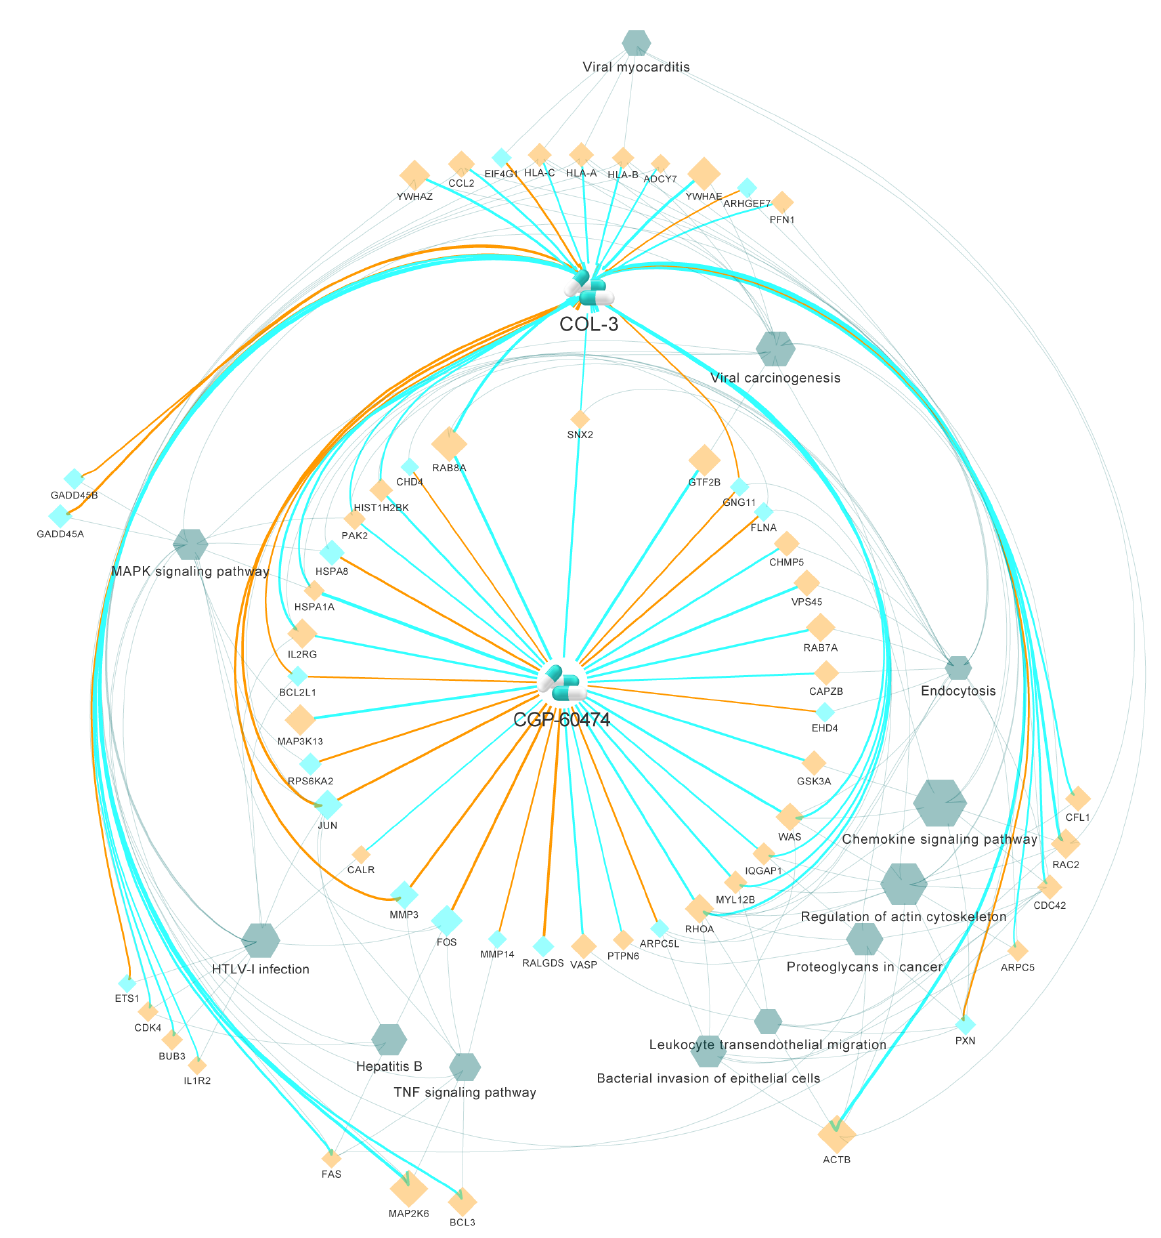
Figure 4. Target genes and pathways of COL-3 and CGP-60474 in treating lung injury in COVID-19. All pathways were significant enriched in both human COVID-19 patient lung tissues and HCC515 cells with ACE2 inhibitor inhibition. The abnormal gene expression patterns in these pathways were reversed by COL-3 and/or CGP-60474. Blue diamond: down-regulated gene in disease; orange diamond: up-regulated gene in disease; hexagon: pathway; blue line: drug decreases gene expression; orange line: drug increases gene expression; blue/orange line width corresponds to the ability to change gene expression; dark green line: interaction between gene and pathway; diamond size: importance of gene in the disease; hexagon size: importance of pathway in the